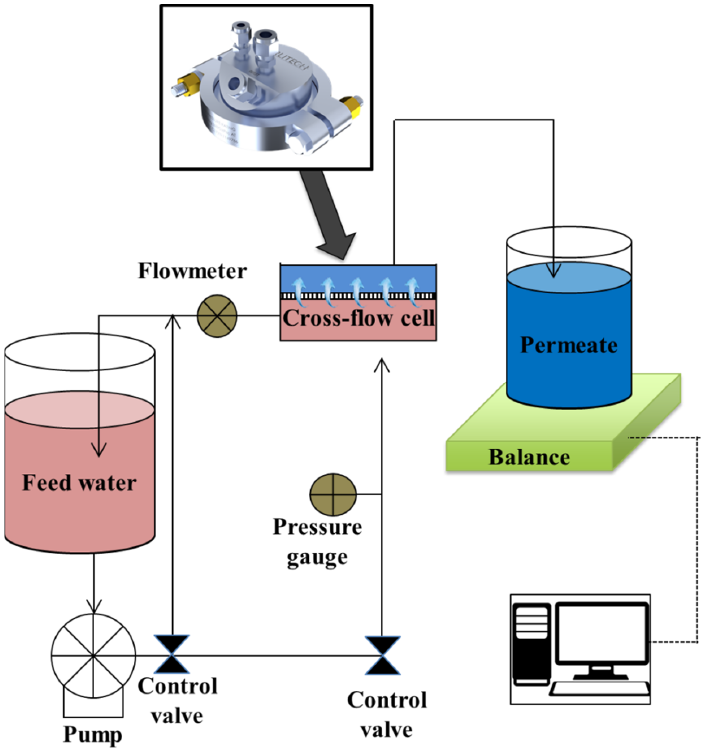
Figure 2. Schematic diagram of the cross-flow membrane module used in the membrane perfor- mance experiments.